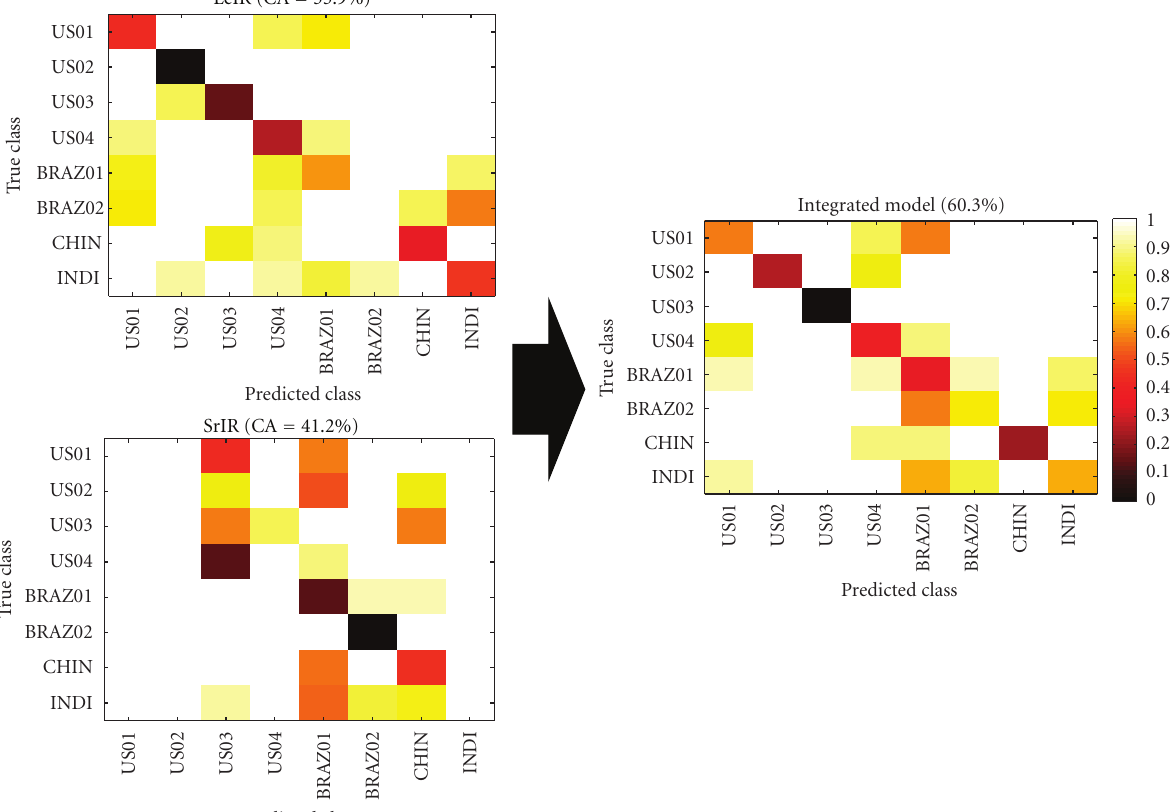
Figure 5: Class accuracy plots show what fractions of the samples are being classified into specific groups, allowing a direct comparison of the true versus predicted classes: the integrated model on the right shows a clear improvement in overall matches between the true and predicted